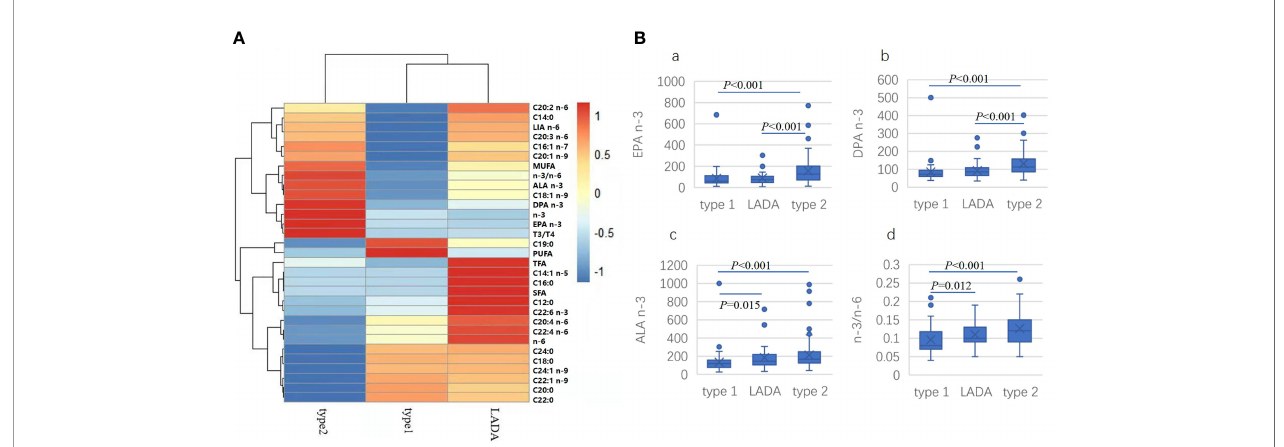
FIGURE 1 | Heatmap drawn for comparison of the correlation of speci fi c fatty acid with different types of diabetes (A) . LA: LIA (C18:2 n-6); MUFA, monounsaturated fatty acid; ALA (C18:3 n-3); DPA (C22:5 n-3); n-3, total n-3 PUFA; EPA, EPA (C20:5 n-3); T3/T4, triene/tetraene PUFA ratio; PUFA, polyunsaturated fatty acid; SFA: saturated fatty acid; n-6, total n-6 PUFA; Comparison of concentration of selected fatty acid indexes in different types of diabetes (B) . (a) EPA (C20:5 n-3), (b) DPA (C22: n-3). (c) ALA (C18:3 n-3), (d) n-3/n-6 PUFA